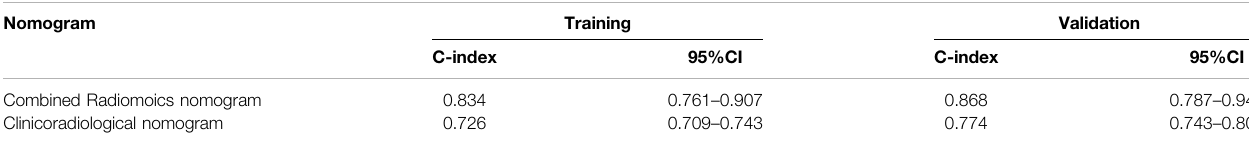
TABLE 5 | Performance of the two nomogram for prediction of disease-free